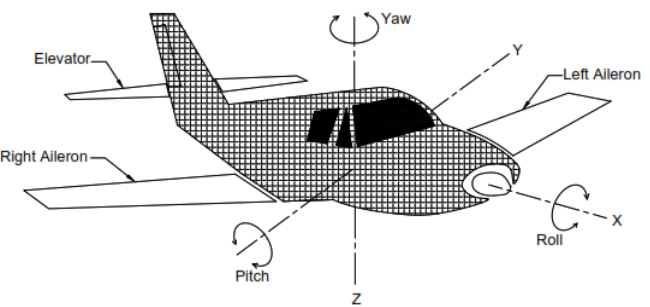
Figure 3. Fixed Figure 3. Fixed Wing.